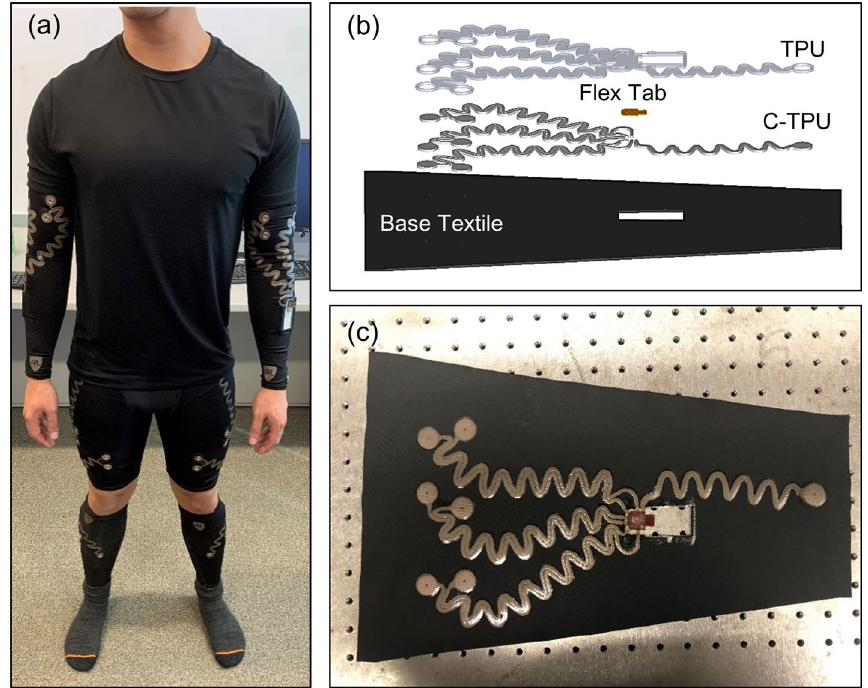
Figure 1. ( a ) Subject wearing the final sEMG suit showing arm sleeves, shorts, and calf sleeves. Fabrication of top side of the sEMG sleeves showing an ( b ) exploded view of sleeve stack up and ( c ) image of the assembled